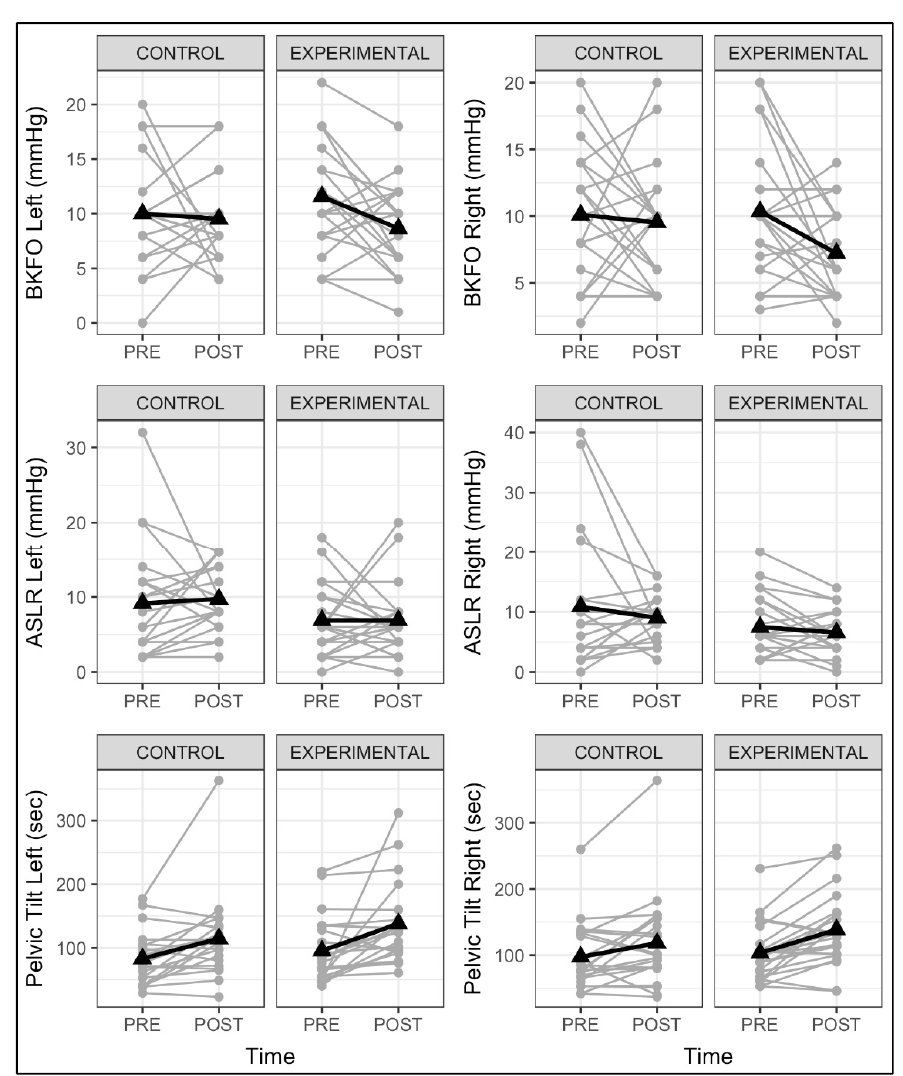
Figure 3. Individual variability results in all CS tests.